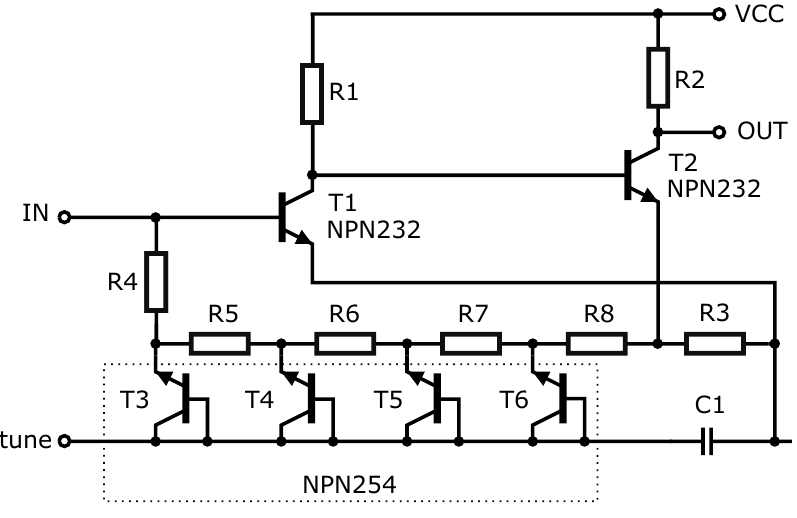
Figure 10. Simplified schematic of the proposed filter stage